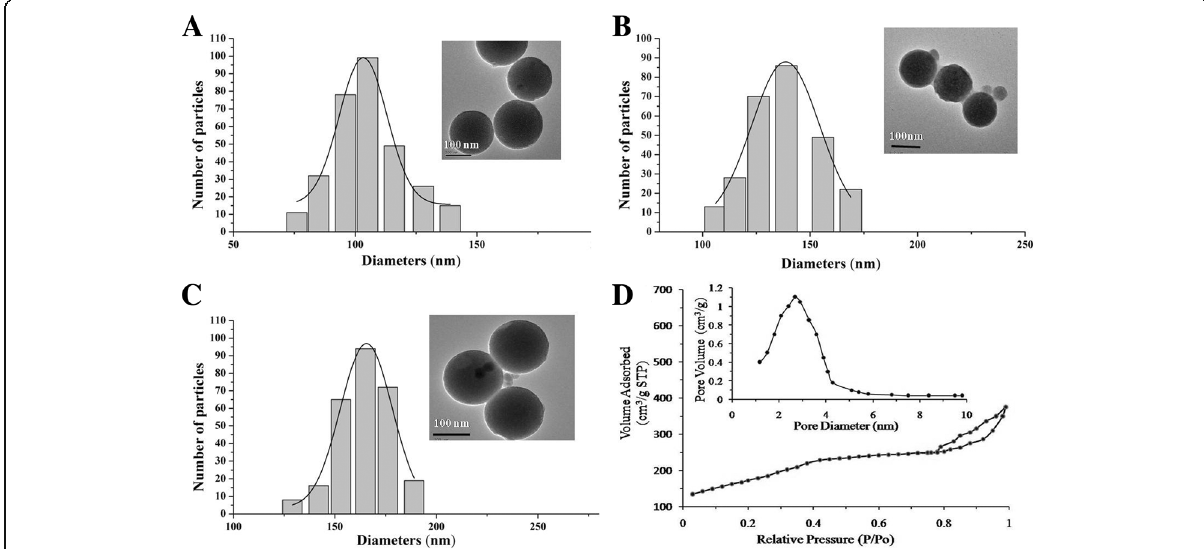
Fig. 1 The characteristics of nanoparticles. Characterizations of MSNs ( a ), BSA-MSNs ( b ), BSA-MSNs-anti-VEGFR2 ( c ), and nitrogen adsorption- desorption isotherm and Barrett – Joyner – Halenda (BJH) pore size distribution curves of MSNs ( d ). The transmission electron microscopy images show that all had regular (uniform spherical) morphology. The dynamic light scattering images show that all were uniform, with average sizes of 108 nm, 139 nm, and 163 nm, respectively. BET and BJH analyses demonstrated typical type-IV isotherms, consistent with a mesoporous